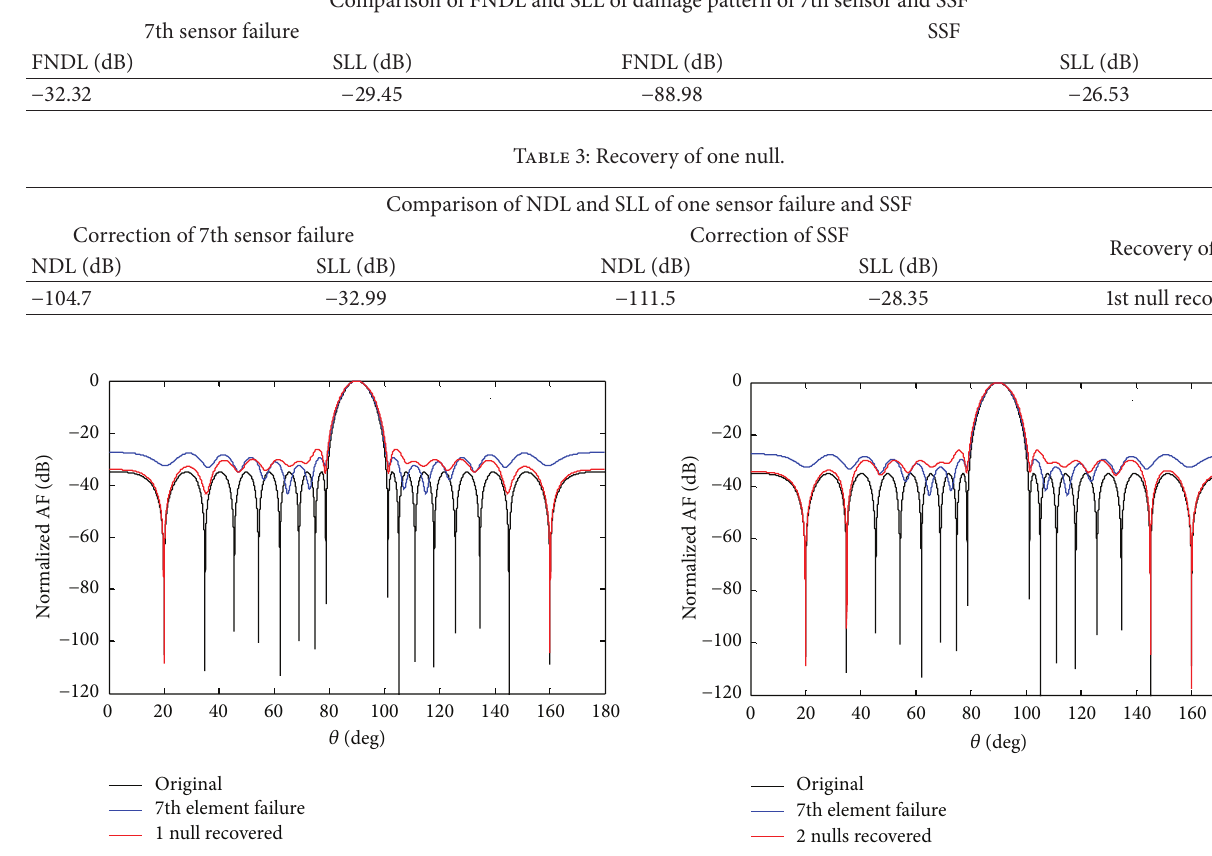
Figure 6: The original radiation pattern, the 𝑤 7 sensor damage, and recovery of two nulls.